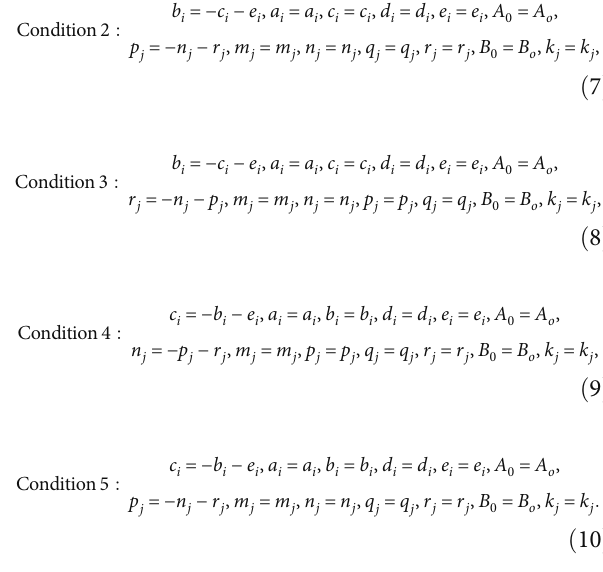
Figure 1: The parameters of μ n 3 = q 3 = r 3 = 2, y = t = s = 0 . (a) Three-dimensional map. (b) Contour